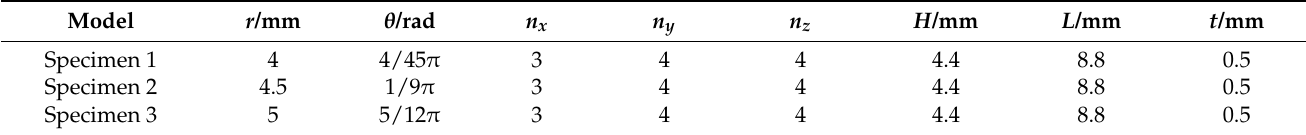
Figure 17. Experimental equipment and specimen. Table 5. Geometric parameters of origami honeycomb used in